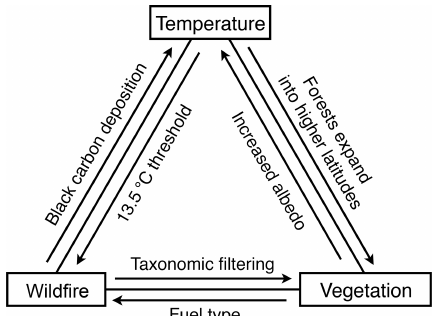
Figure 6. Examples of the feedbacks between temperature, vegeta- tion and wildfire at the Beaver Pond site.